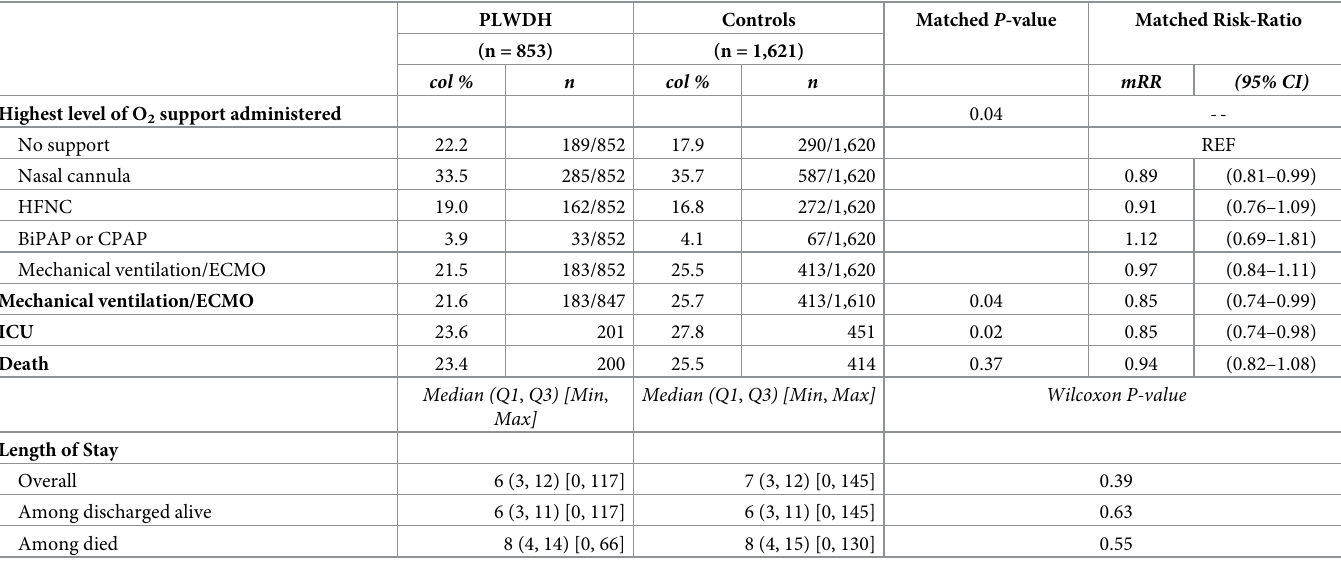
Table 4. Hospitalization outcomes among PLWDH and matched